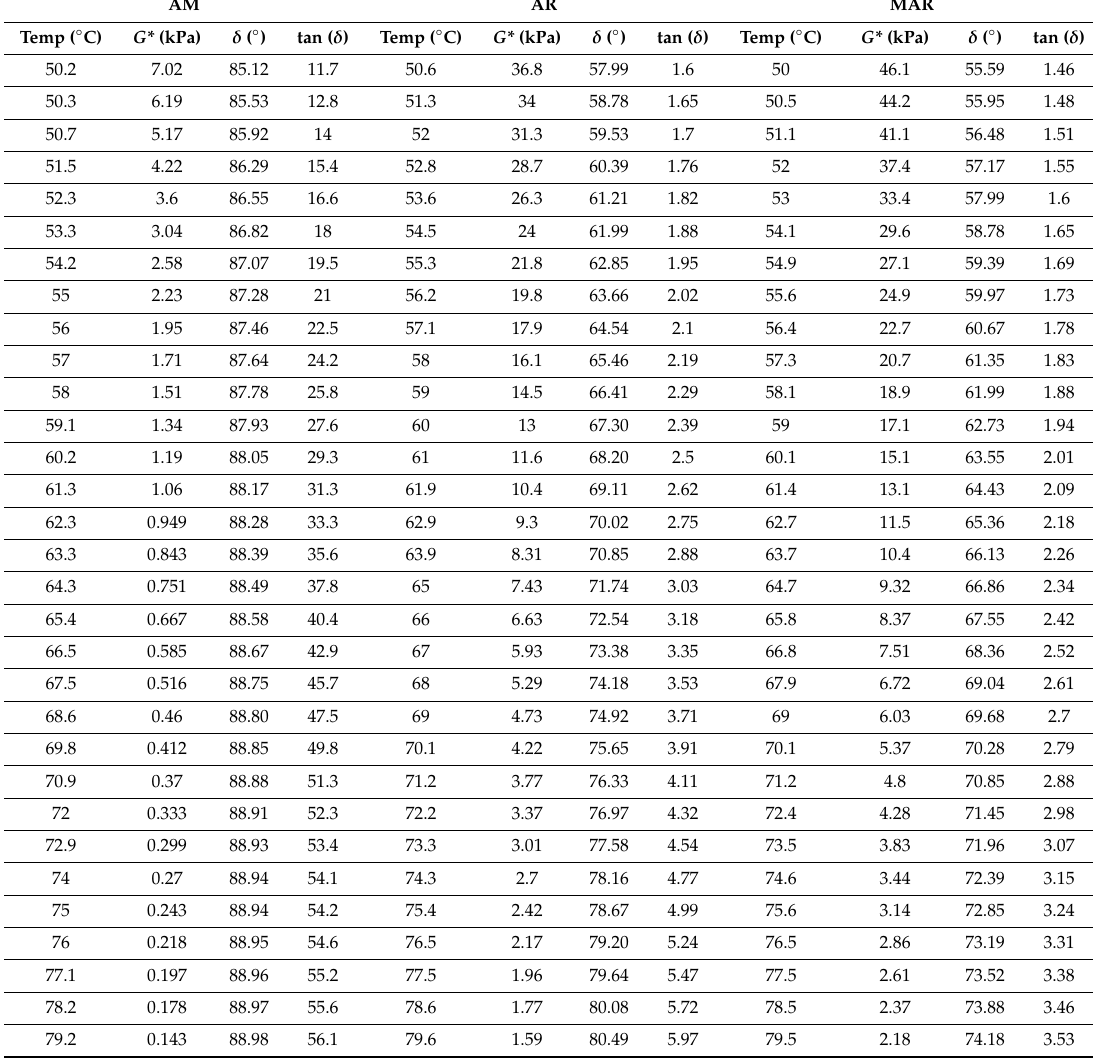
Table 4. DSR temperature scanning test